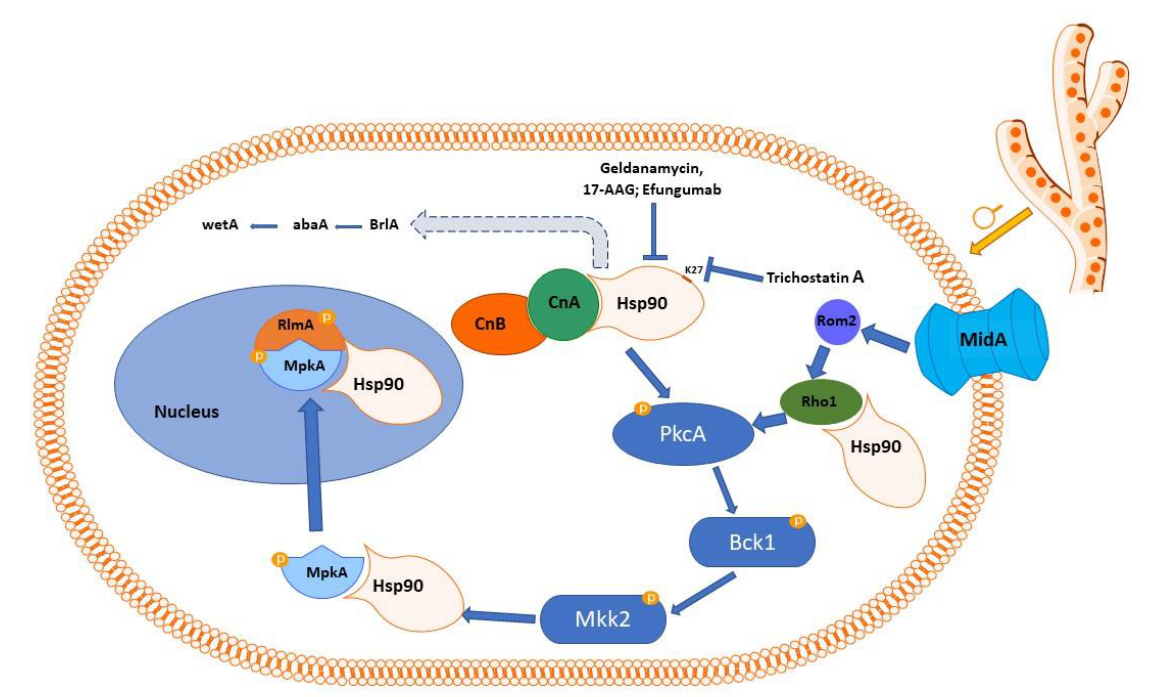
Figure 2. Schematic representation of Hsp90 signaling pathway in Aspergillus sp. Calcineurin is chaperoned by Hsp90, which stabilizes it. There seems to be a number of physical interactions between calcineurin and Hsp90, but our understanding of these interactions is currently limited (more evidence is available for Candida and less for Aspergillus ). Protein kinase C (pkcA) is an Hsp90 client (there is also evidence of at least genetic cross-talk between CnA and pkcA). Heat shock response is initiated by the calcium channel MidA, which acts as a stress sensor. The stress signals are integrated by Rom2, which is regarded as the first upstream activator of the cell wall integrity pathway and is a guanine nucleotide exchange factor (GEF). Rom2 activates the Rho1 GTPase, which in turn activates pkcA (Rho1 is also an Hsp90 client) [119,120]. The latter triggers activation in cascade o Bck1 (bypass of protein kinase C), Mkk2 (mitogen-activated kinase kinase), and Mpka (a MAPK, client of Hsp90, known to regulate the expressions of α -1,3-glucan synthase genes). Mpka could also be activated by Wsc 1,2,3 proteins, which are general stress sensors at cell wall levels in fungi, although direct evidence in Aspergillus seems not to be available yet [121]. MpkA is translocated to the nucleus, where it activates, by phosphorylation, the RlmA transcription factor, whose activity is necessary for the transcription of genes encoding enzymes responsible for cell wall formation and which is also an Hsp90 partner [119]. Furthermore, Hsp90 is somehow involved in activating the expression of brlA (possibly also of abaA and wetA ). In its turn, BrlA regulates other genes involved in conidiation, among which the most important seem to be abaA and wetA .